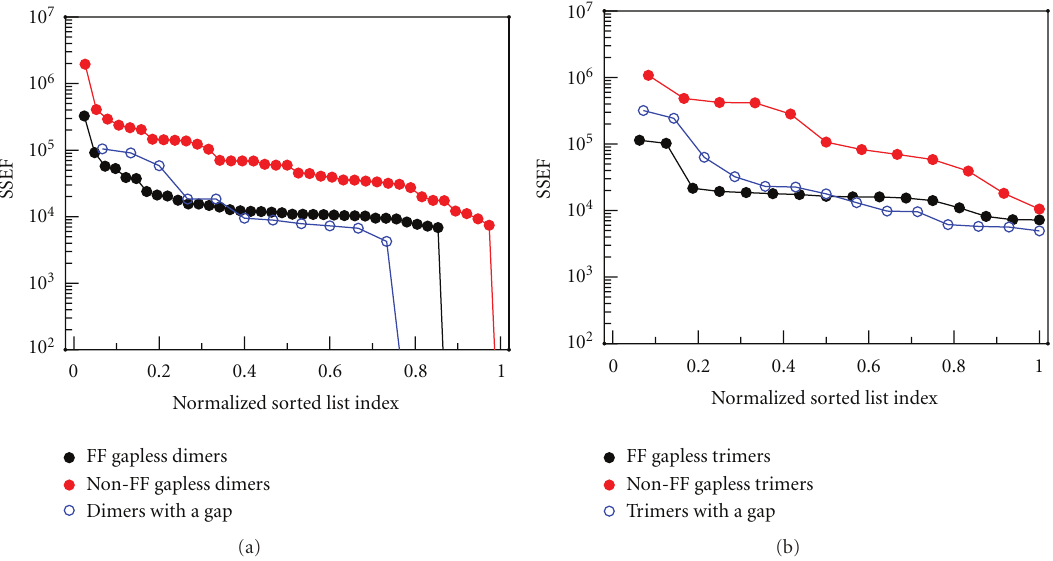
Figure 7: Cluster configuration analysis. Sorted SSEF data from (a) silver nanocube dimers and (b) silver nanocube trimers. The categories are FF clusters with no gaps (black), non-FF clusters with no gaps (red), and clusters with a gap (blue, open circles). Excitation wavelength: 633nm. Nanocube size: 110